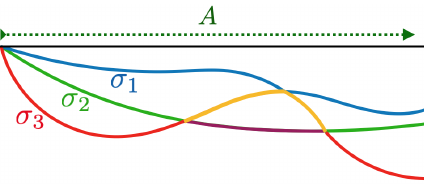
FIG. 11. Lattice magnet with deterministic measurements. In the limit of large local Hilbert-space dimension with determinis- tically applied projective measurements, the replicated descrip- tion of the entanglement is given by a uniform sum over all S n domain-wall configurations, which end at the boundaries of the A subsystem, and are directed along the spatial direction. Shown is a schematic configuration of domain walls in the n = 4 ( S 4 ) lattice magnet. When these domain walls intersect, the total transpositions appearing in the decomposition of the “ingoing” and “outgoing” domains is conserved, yielding a description as a partition function for ( n − 1 ) -directed walkers with an attractive